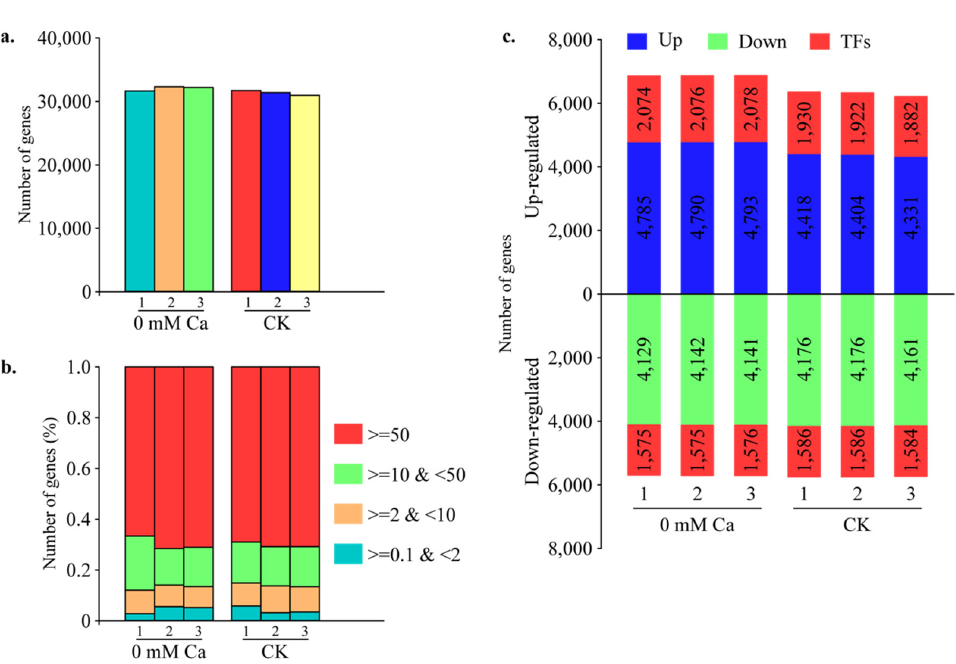
Figure 2. Pearson correlation and PCA analysis. ( a ) Pearson correlation between samples. ( b ) Principle component analysis between samples.